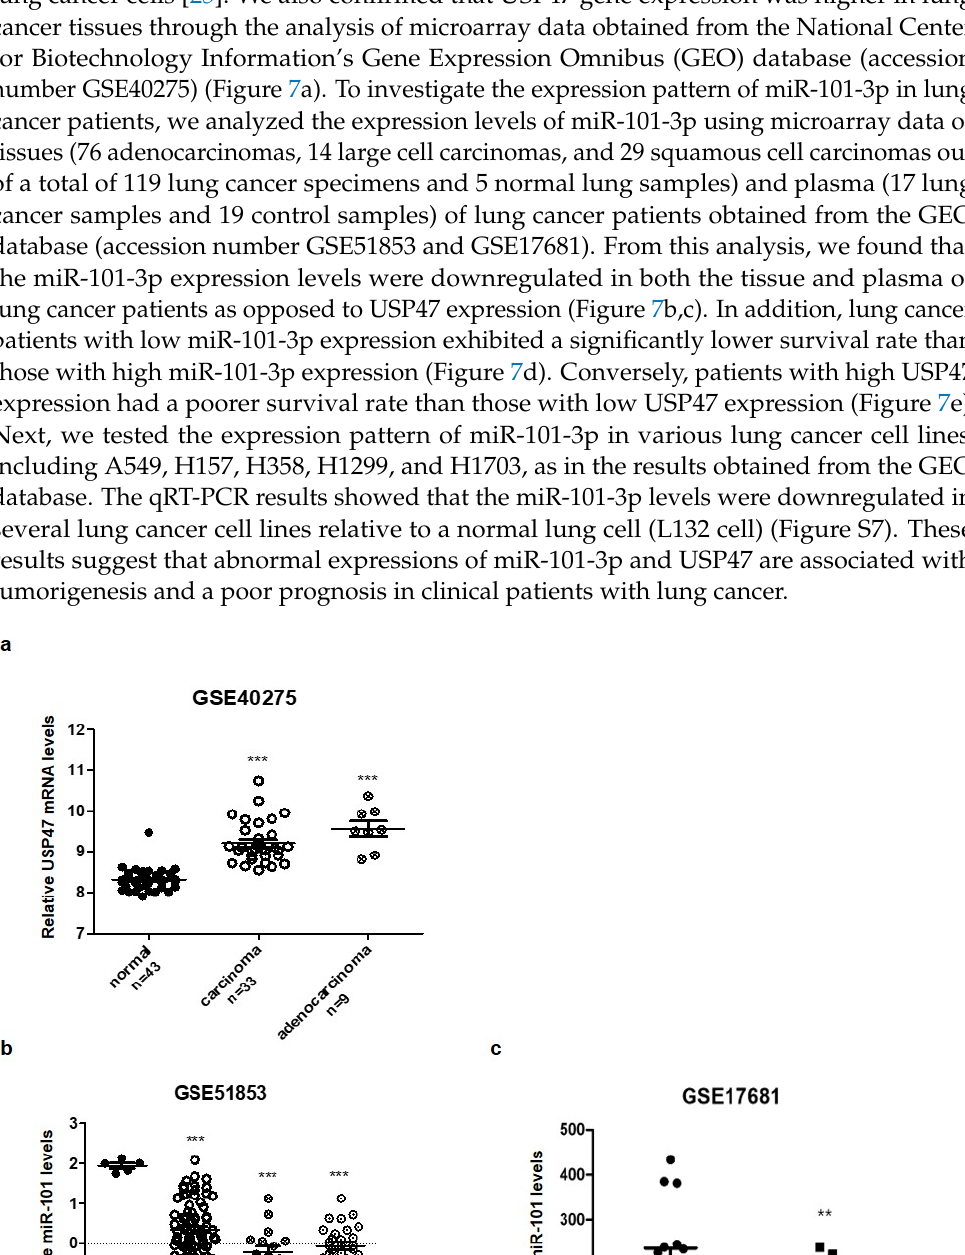
Figure 7. MiR-101-3p is downregulated in lung cancer. ( a ) USP47 expression level was analyzed in adjacent normal tissues ( n = 43) and lung cancer tissues ( n = 33, n = 9) (GSE40275). ( b , c ) MiR-101-3p expression levels were analyzed in: ( b ) adjacent normal tissues ( n = 5) and lung cancer tissues ( n = 119) (GSE51853); and ( c ) control ( n = 19) and patient ( n = 17) blood samples (GSE17681). ( d , e ) Kaplan–Meier analysis of survival rates according to: ( d ) miR-101-3p; or ( e ) USP47 expression in